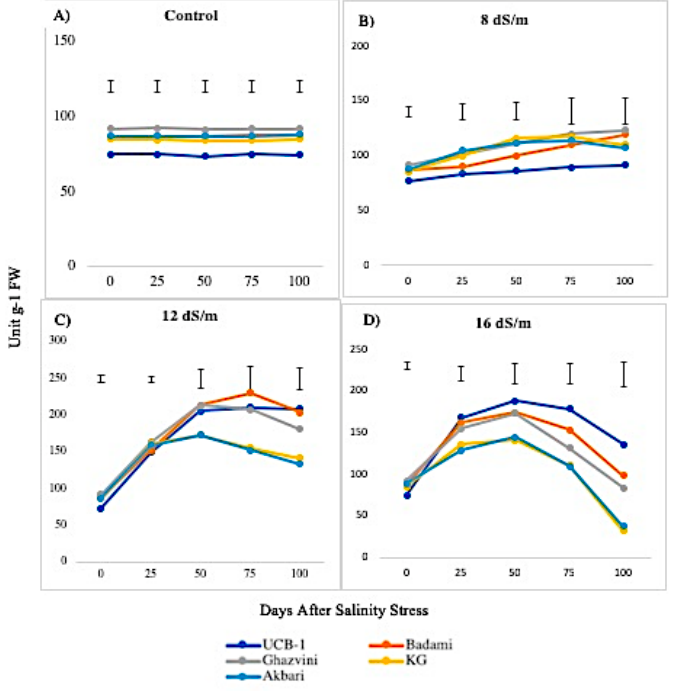
Figure 1. Effect of NaCl-mediated stress on SOD activity in leaves of pistachio. Figure 1. E ff ect of NaCl-mediated stress on SOD activity in leaves of